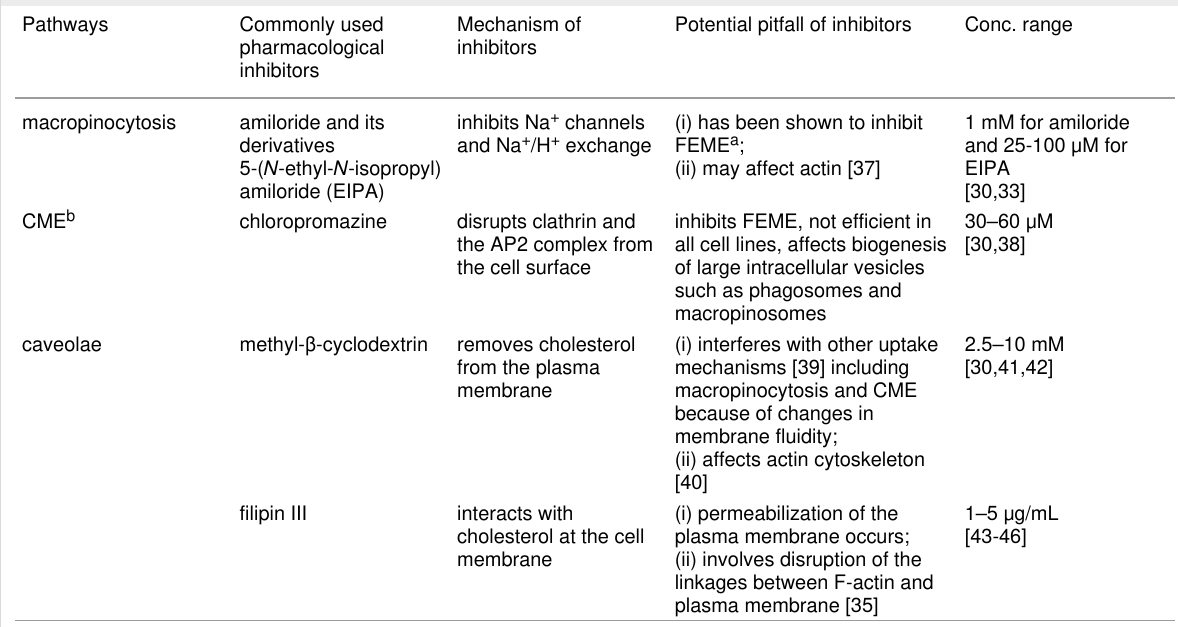
Table 2: Toolbox of pharmacological inhibitors used to study endocytosis pathways.